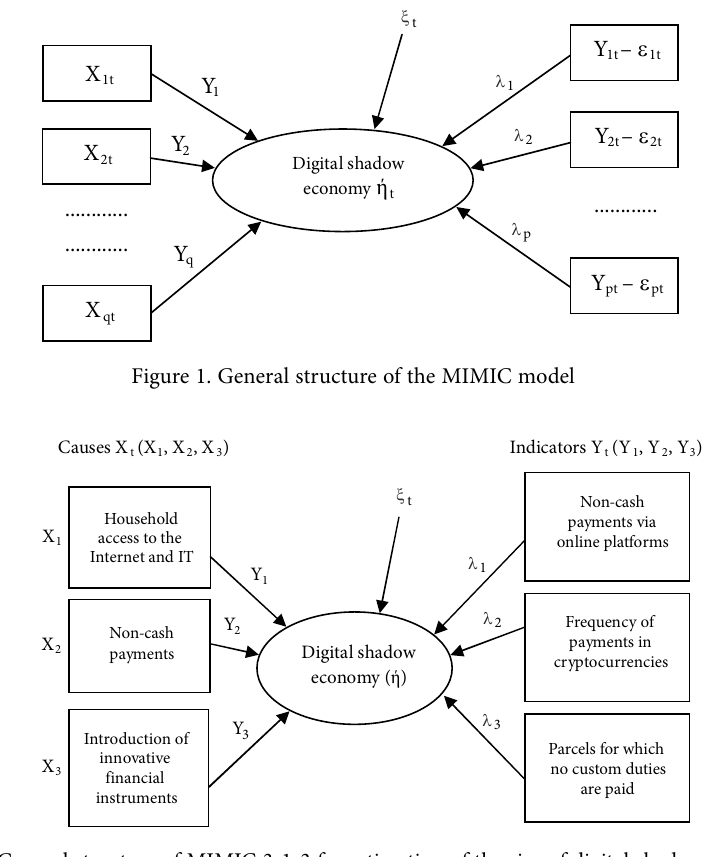
Figure 2. General structure of MIMIC 3-1-3 for estimation of the size of digital shadow economy. Numbers 3-1-3 mark that 3 causal variables, and 3 indicators are included in the